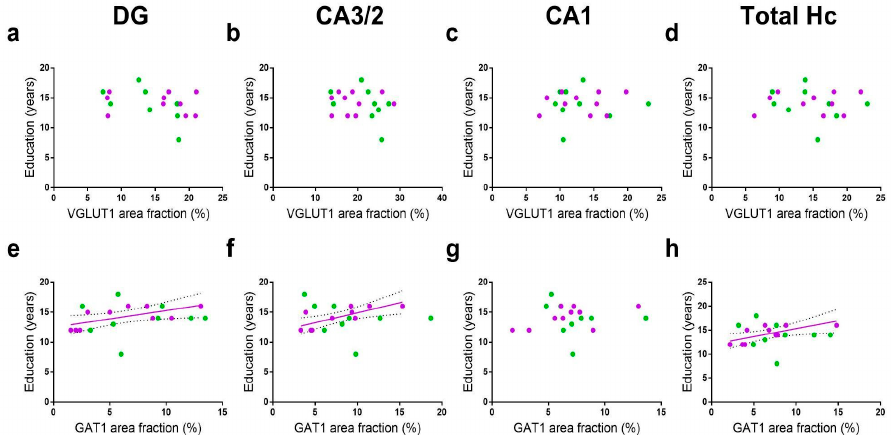
Figure 5. Pearson’s correlations between VGLUT1 ( a – d ) and GAT1 ( e – h ) area fractions with education years. Analysis was performed in the total pool of donors as well as donors divided in female (purple) or male (green) groups. Area fractions are plotted as a function of education years in the DG, CA3/2, CA1, and total hippocampus (Hc). Regression lines with 95% confidence intervals are shown when a significant ( p < 0.05) relationship is observed.